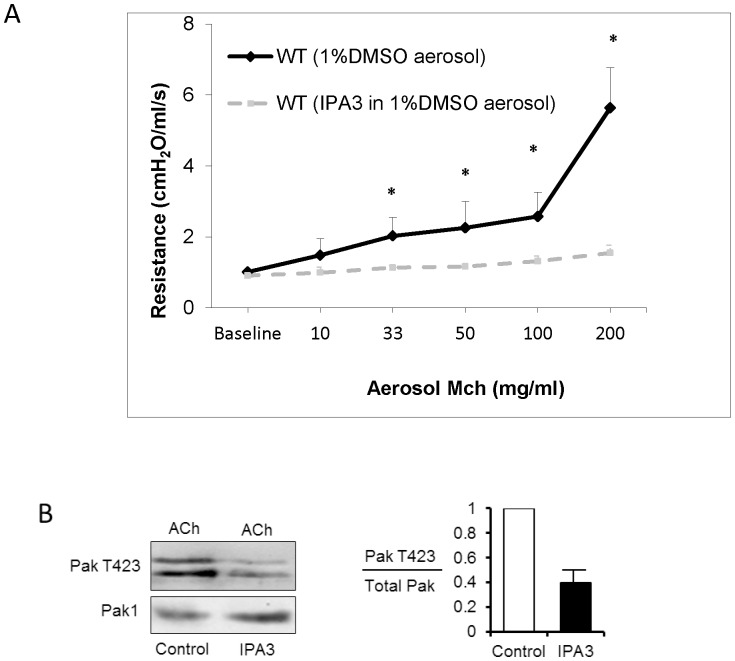
Aerosolized IPA3 inhibited airway contractility in vivo and suppressed Pak activation.When assessed by repeated ANOVA, resistance increased with increasing ACh dose (p<0.0001), and IPA3 dissolved in 1% DMSO (N = 3) and aerosolized 1-hour prior to bronchial challenge of WT mice significantly reduced the slope of the increase in resistance (p<0.0001), as well as the magnitude of the increase in resistance compared to control vehicle (1%DMSO; N = 5) (p<0.001) (A). Post-hoc analysis indicated that IPA3 treatment resulted in lower resistances at MCh doses ≥33 mg/ml (p<0.05). Tracheal smooth muscle isolated from WT mice treated in vivo with IPA3 demonstrated significantly lower Pak activation as assessed by Pak T423 phosphorylation following stimulation with ACh compared to airway smooth muscle isolated from WT mice (B). Results represent 2 samples of tracheal smooth muscle from each group. Each sample consisted of pooled tracheal muscle tissues from 3 separate mice with the same treatment.